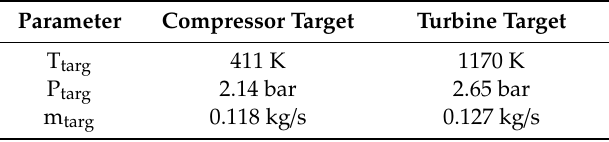
Figure 8. Turbine map for di ff erent dimensionless speeds. Table 2. Target conditions for